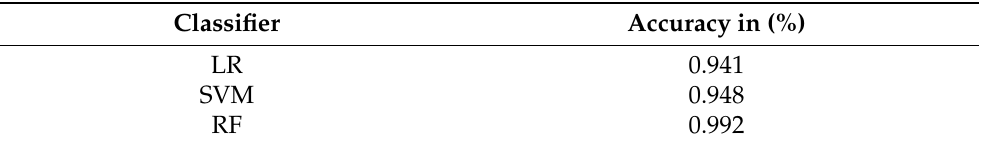
Figure 3. l -diverse constraint slicing and base paper’s model comparison analysis of different classifiers (LR, RF and SVM) over 10 folds. Table 12. Accuracy comparisons of different